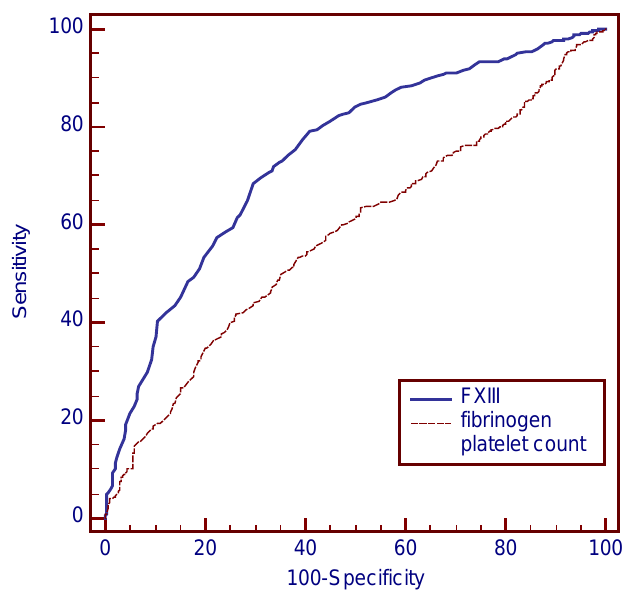
Figure 1. Comparison of ROC curves: The AUCs for FXIII, platelet count and fibrinogen concentration were significantly different from each other, indicating that FXIII activity was a significantly better predictor of red cell transfusion than platelet count and fibrinogen concentration.